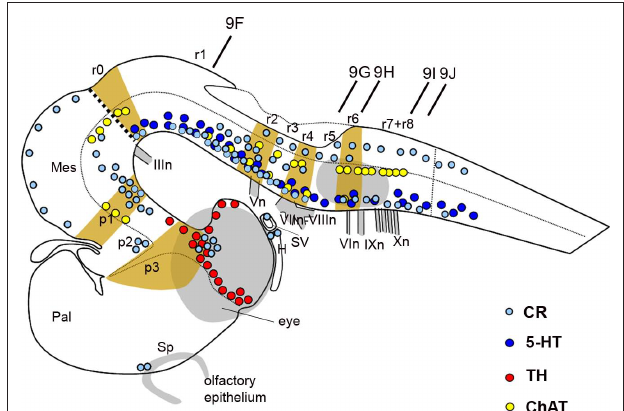
Figure 8 | Schematic representation of the embryonic brain at stage 29 showing the distribution of Cr- (bright blue dots), 5-HT- (dark blue dots), TH- (red dots), and ChAT-ir (yellow dots) immunoreactive cells and the relation to transverse segments. The dotted line indicates the alar–basal boundary. The vertical bars indicate the approximate levels of sections of Figure 9 . For abbreviations, see